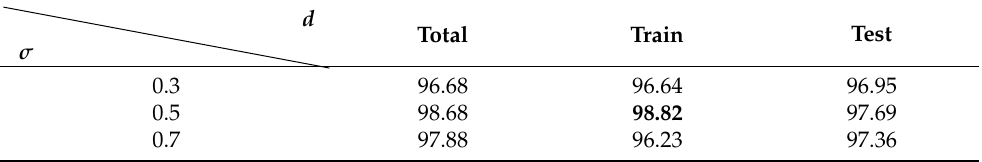
Table 4. Classification accuracy of different parameters in GF (%).